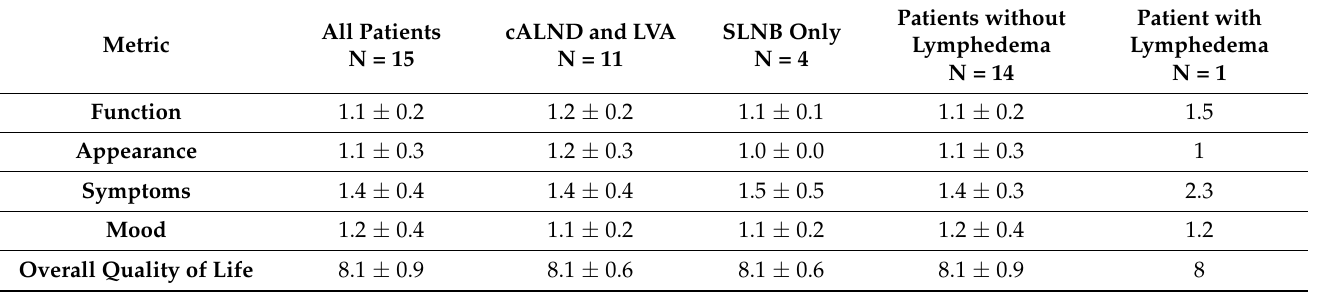
Table 2. Patient-Reported Outcomes with LYMQOL-ARM 1